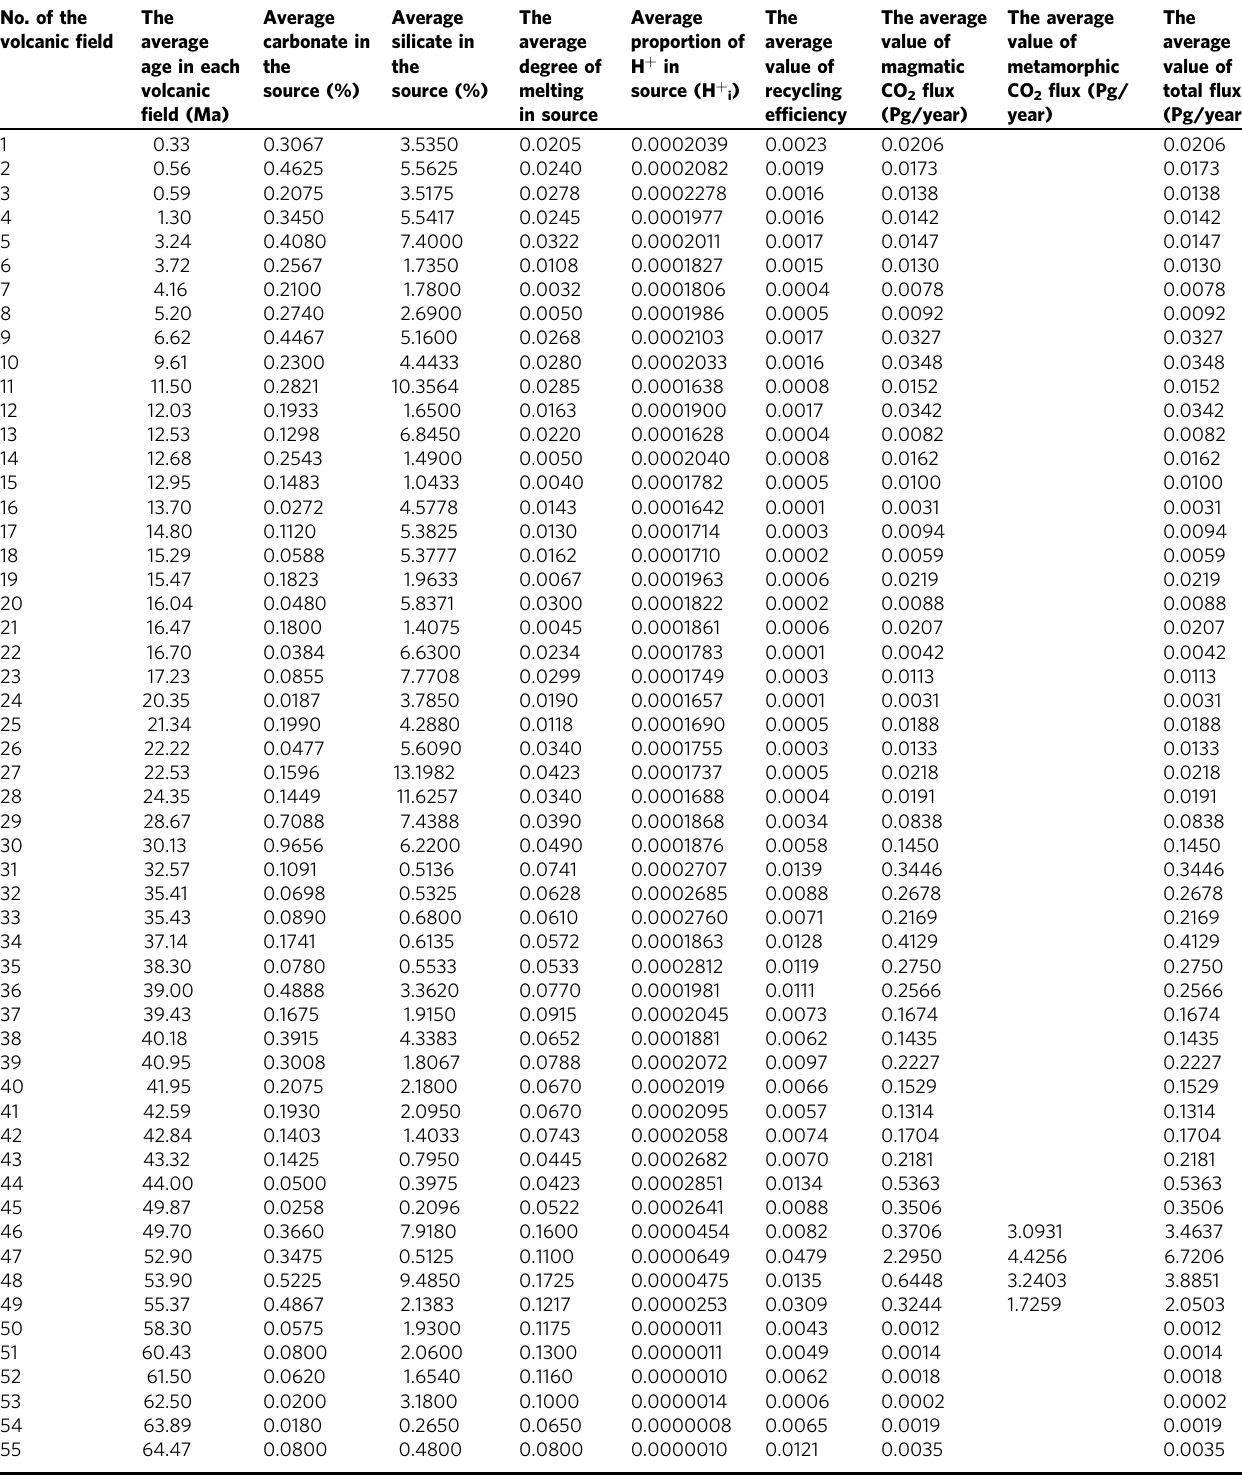
Table 1 Mean value of eruption age, geochemical parameter and CO 2 fl ux from each Cenozoic volcanic fi eld in Tibet. No. of the volcanic fi